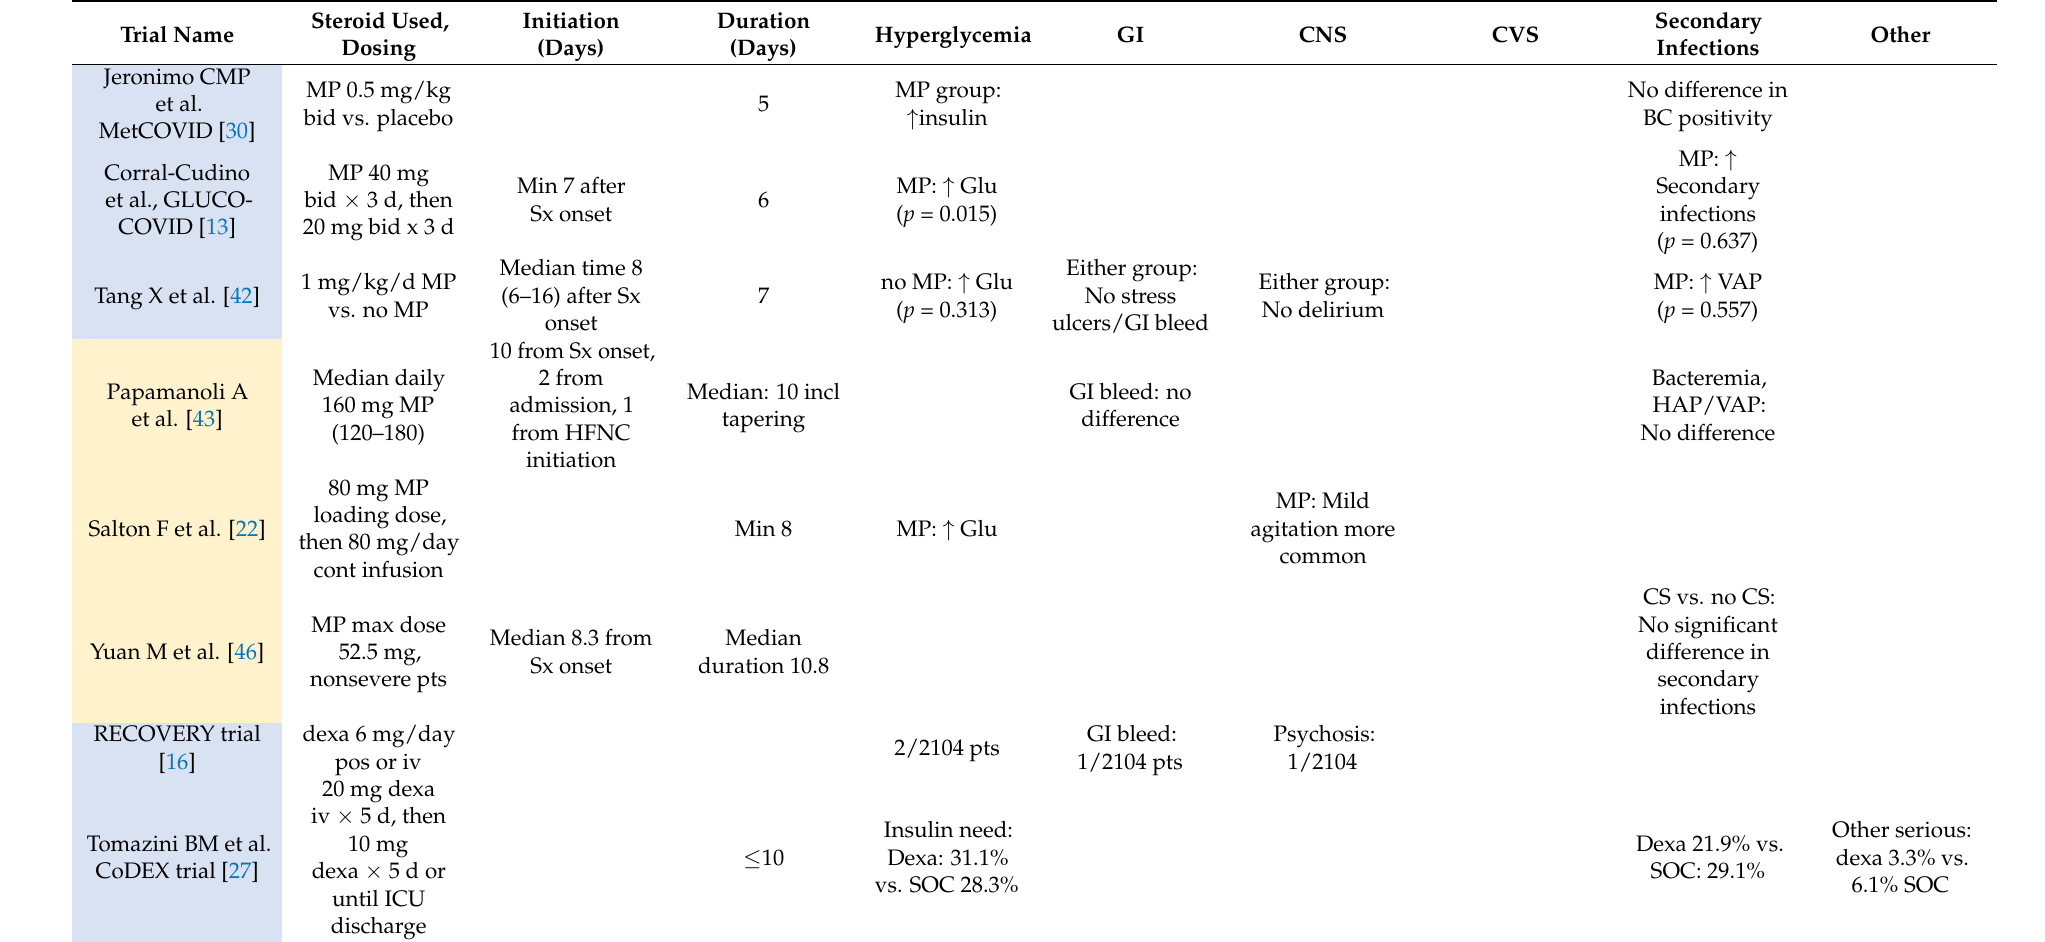
Table 5. Trials and corticosteroid (CS)-related adverse effects (randomized trials in blue, retrospective/observational trials in yellow, and meta-analysis in